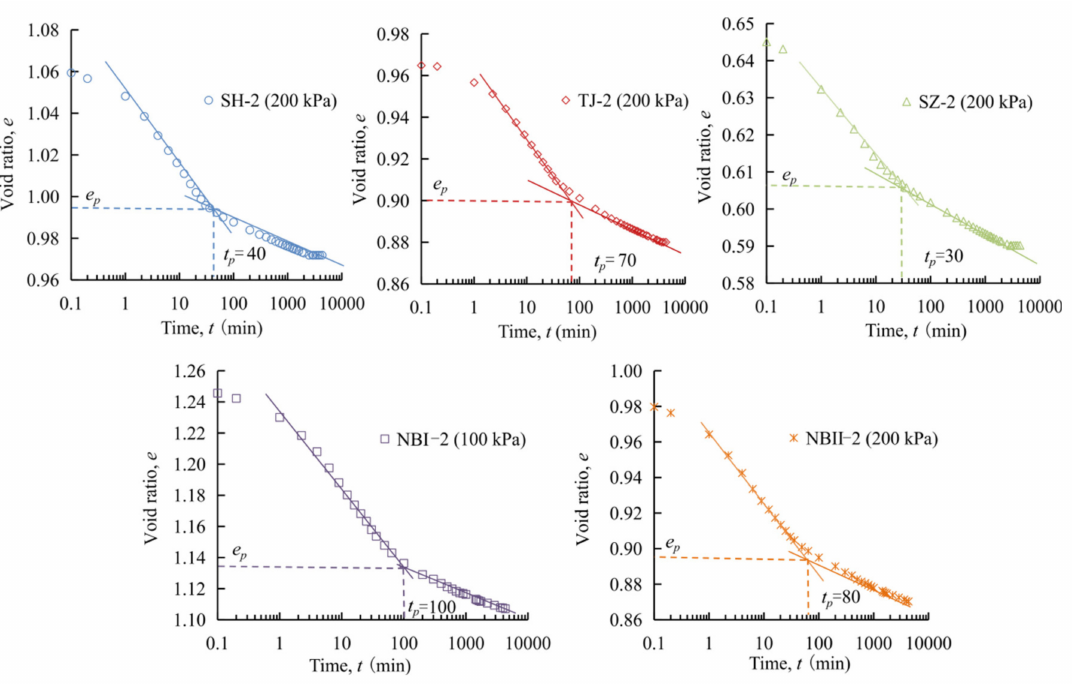
Figure 8. The e -lg t curves of five